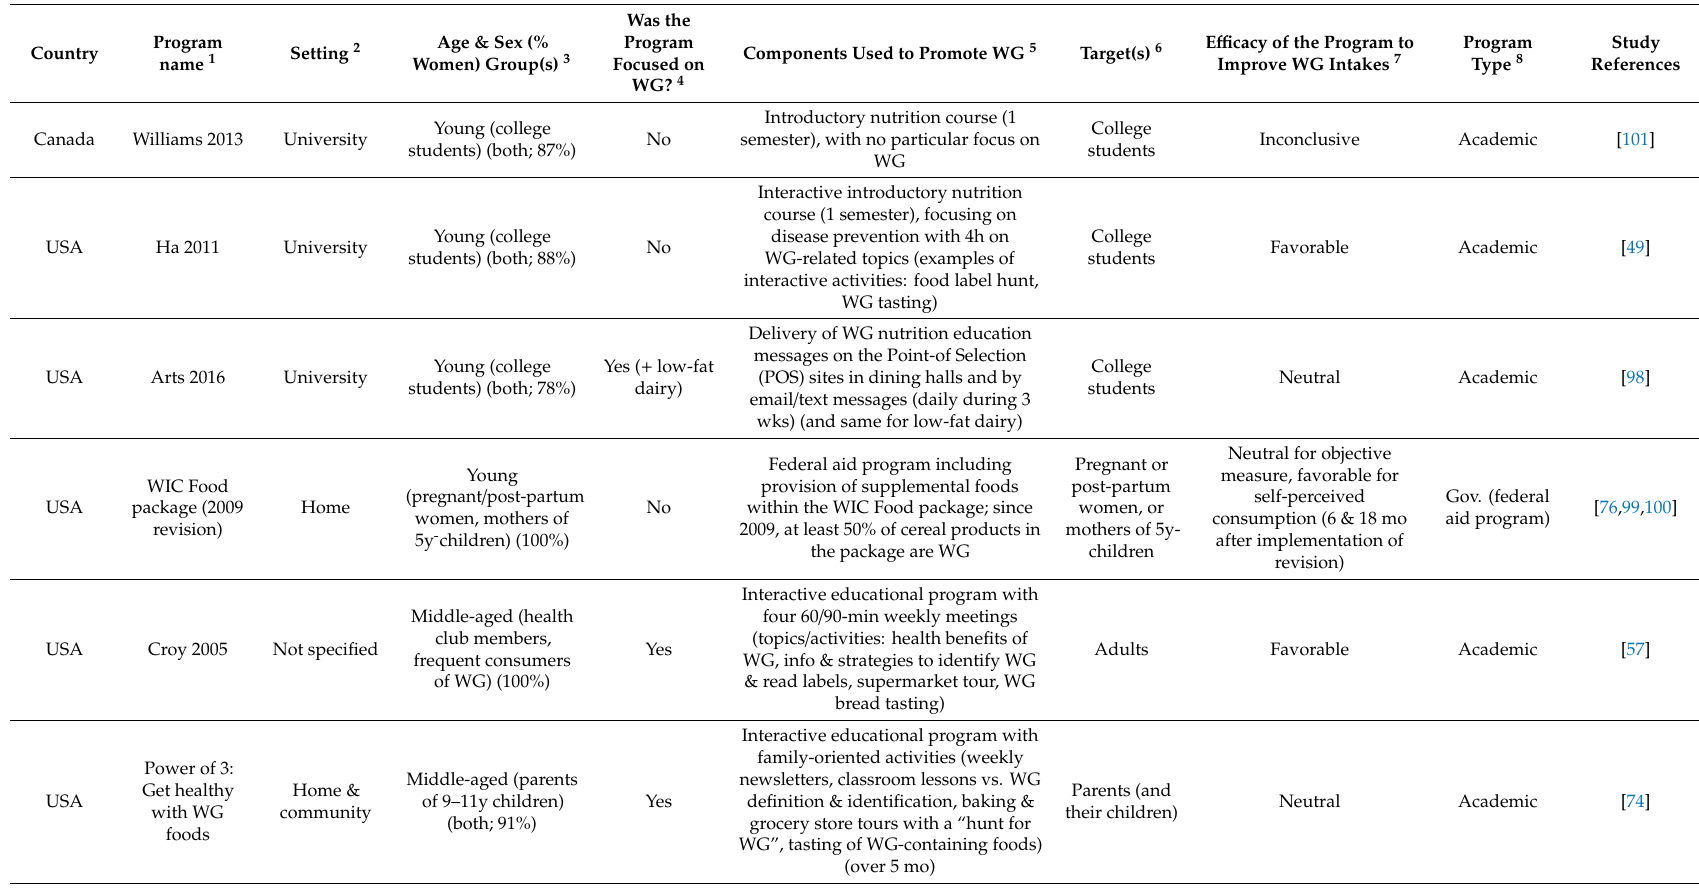
Table 3. Description of programs that aimed at promoting the consumption of whole grains in adults, as identified in the frame of the current review.